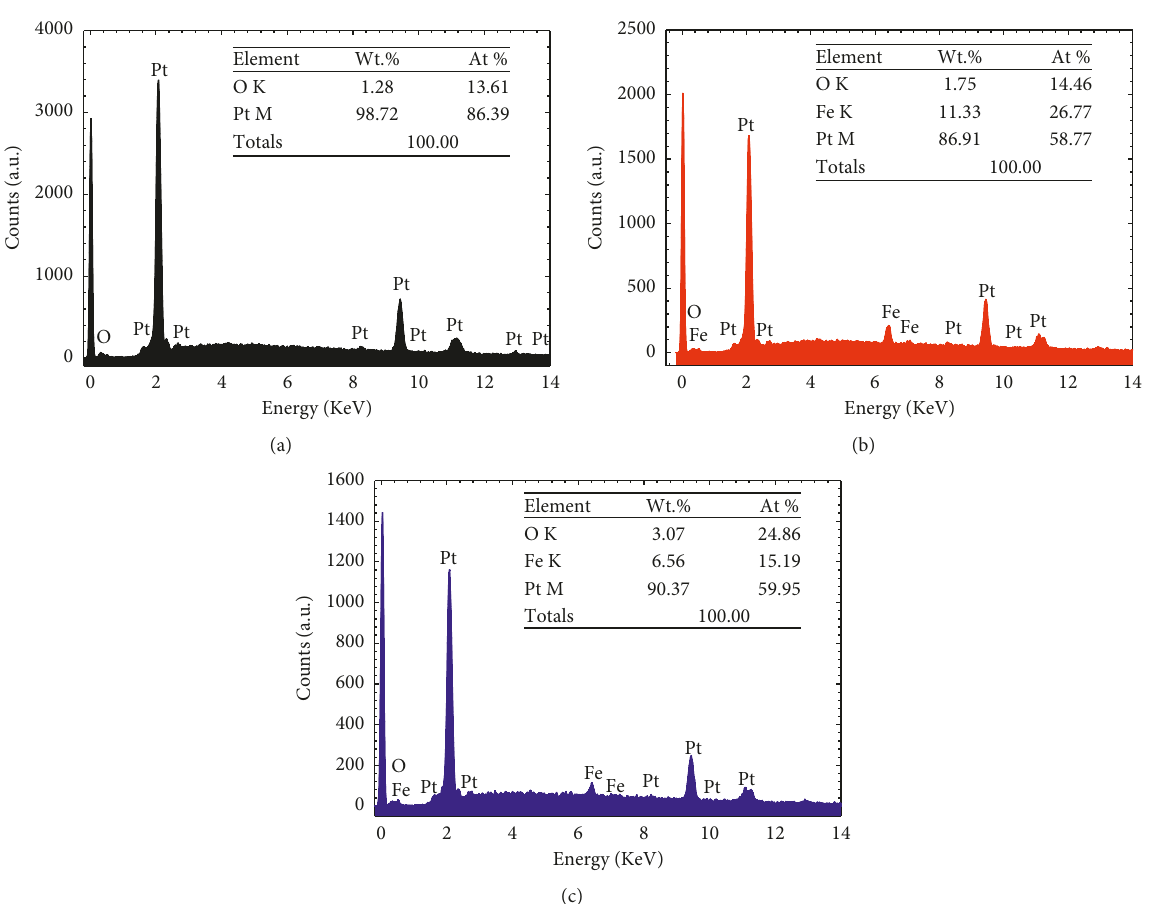
Figure 3: EDX analyses of the bare Pt (a), FeOx/Pt (b), and a-FeOx/Pt ( − 0.5 V) (c) catalysts.